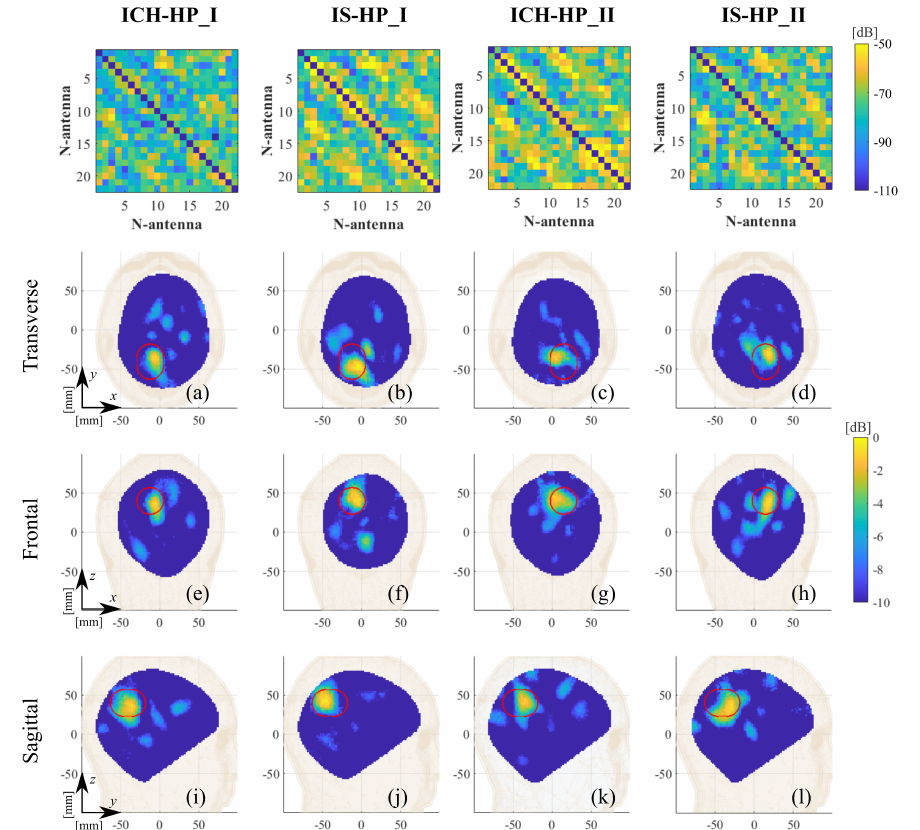
Figure 12. HP calibrated differential scatting matrices (first row) and reconstructed normalized dielectric contrast values. Columns (from left to right): ICH-HP_I, IS-HP_I, ICH-HP_II, and IS-HP_II. ( a – d ) Transverse views, ( e – h ) frontal views, and ( i – l ) sagittal views. The expected stroke area is indicated with a red